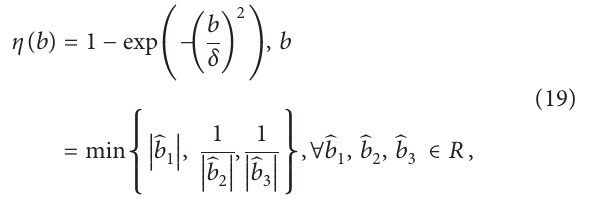
Figure 8. First, the smooth switching algorithm is